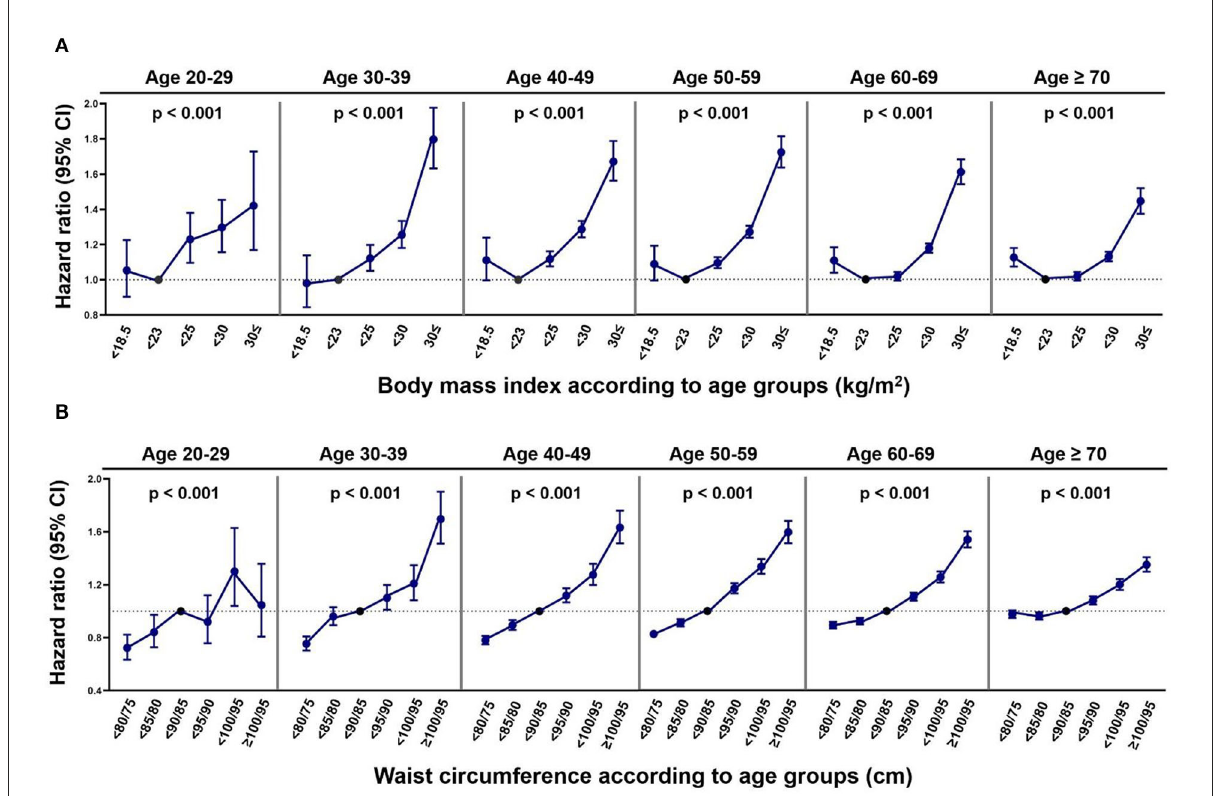
FIGURE2 The risk of atrial fibrillation according to obesity parameters in the different age groups. (A) BMI. (B) WC. CI, confidence interval. P -values indicate the statistical significance of the association between obesity parameters (body mass index, waist circumference) and the risk of atrial fibrillation in each age group by calculating obesity parameters as continuous variables and adjusting covariates noted in model